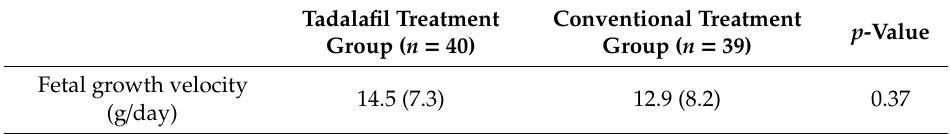
Table 7. Fetal growth velocity as secondary analysis. Data are reported as mean (standard